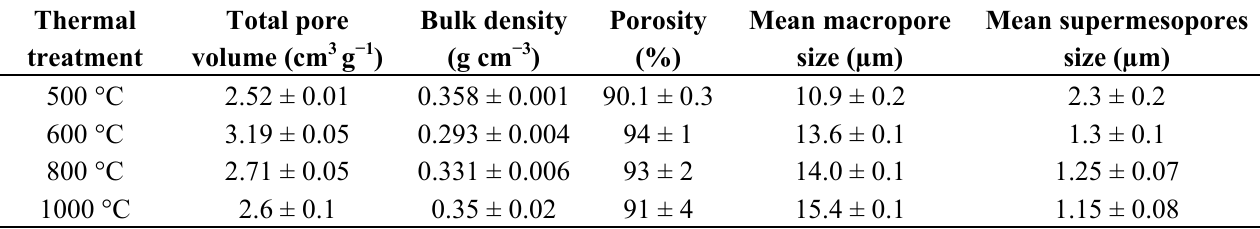
Table 2. Porous characteristics of zirconia foams prepared with 10% SDS and fired at different temperatures.